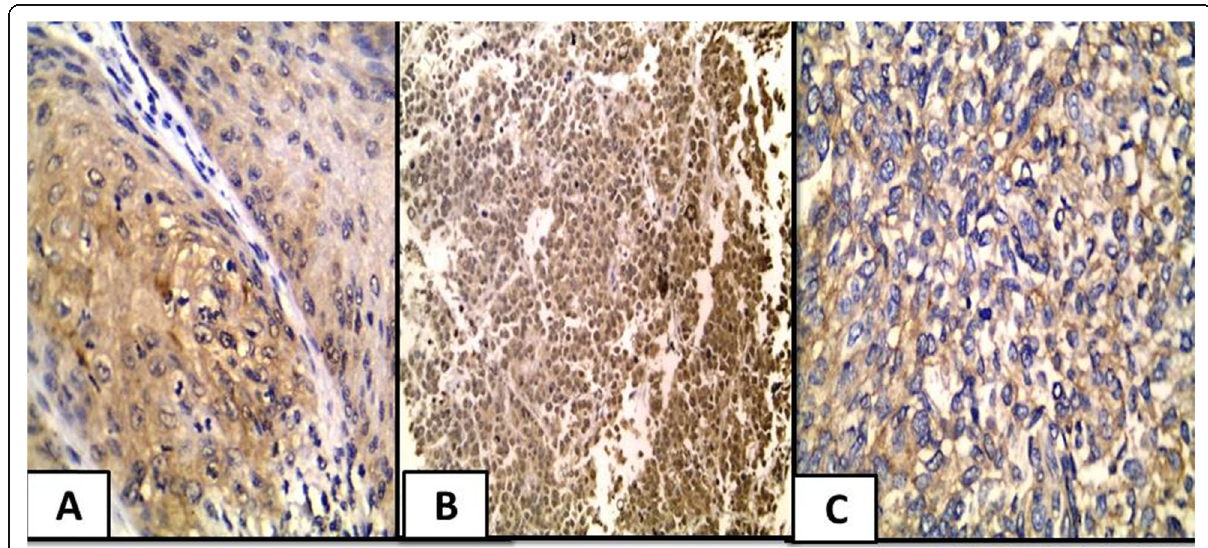
Fig. 1 ROC-1 expression in studied cases. a A case of moderately differentiated squamous cell carcinoma showed positive moderate cytoplasmic expression of ROC-1 (IHC × 200/400). b A case of small cell neuroendocrine carcinoma showed positive strong nucleocytoplasmic expression of ROC-1 (IHC × 200) c A case of invasive urothelial carcinoma, high grade showed positive mild cytoplasmic expression of ROC-1 (IHC ×